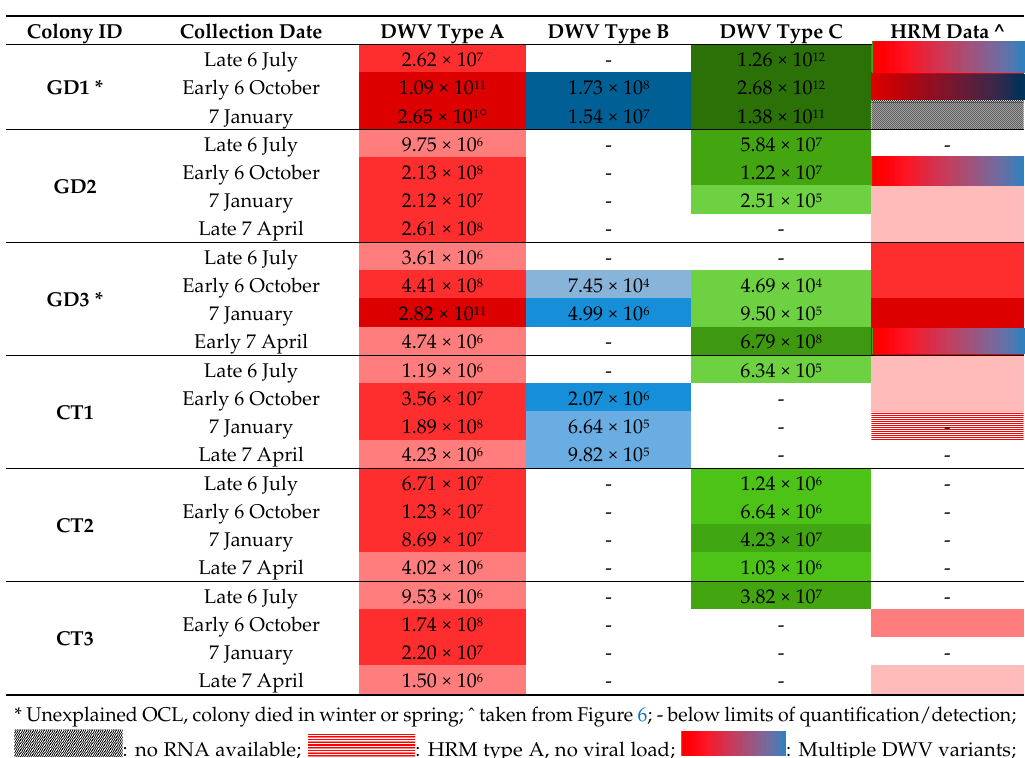
* Unexplained OCL, colony died in winter or spring; ^ taken from Figure 6; - below limits of quantification/detection;